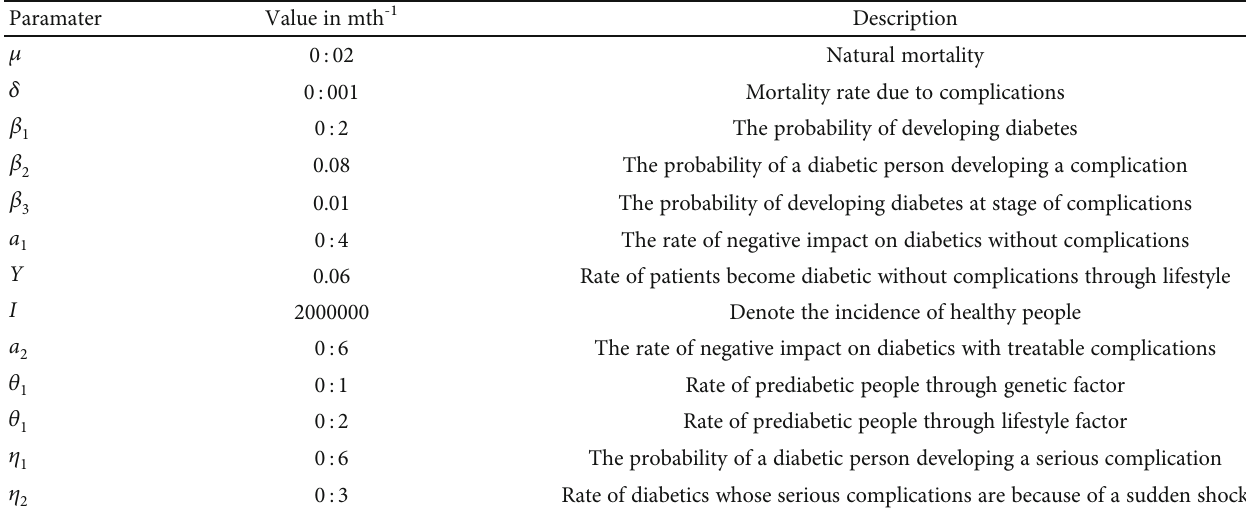
Table 1: Parameter values used in numerical